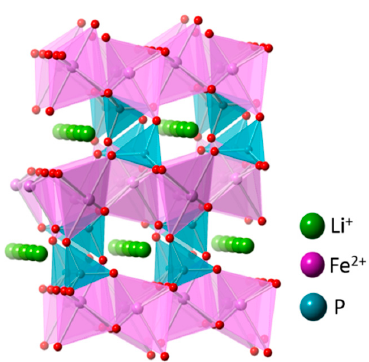
Figure 5. Crystal structure of olivine LiFePO 4 in projection [001] (ICSD no. 56291).